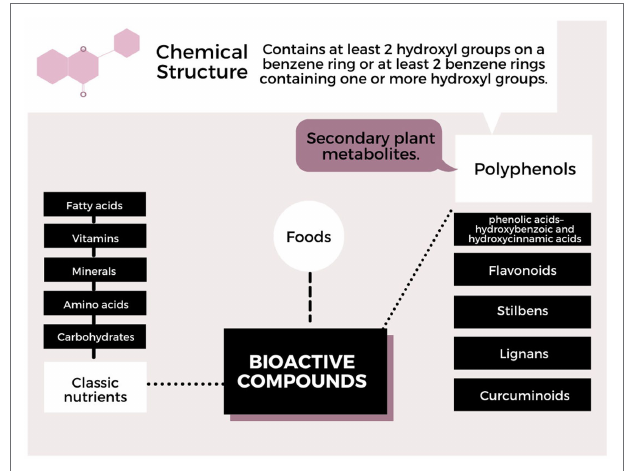
FIGURE 1 | Plant phenolics classes categorized according to their chemical